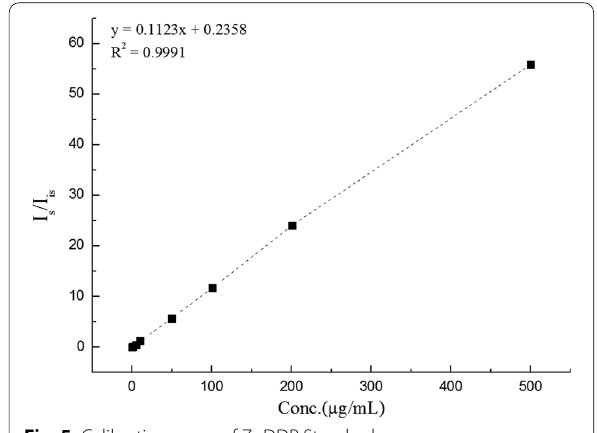
Fig. 5 Calibration curve of ZnDDP Standard